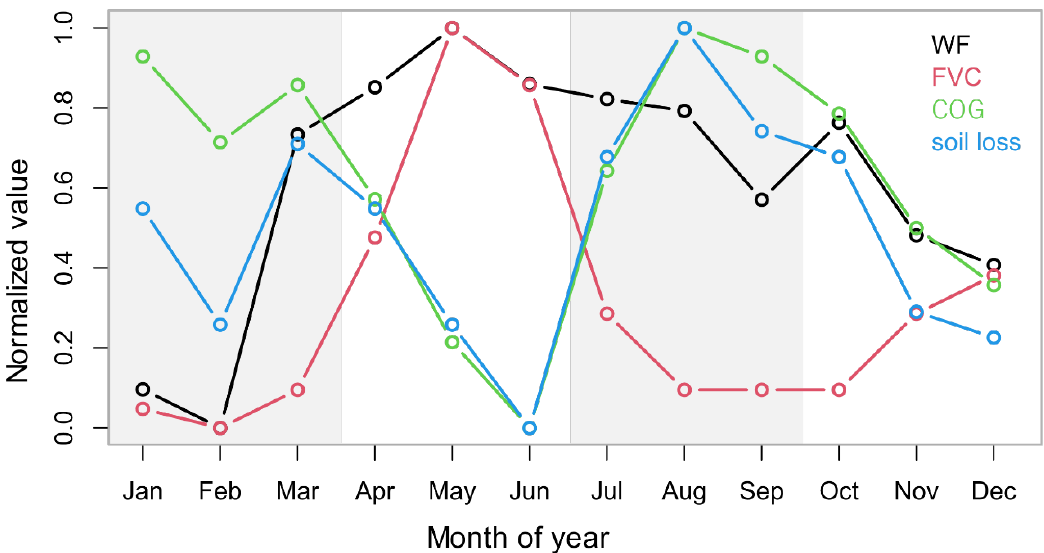
Figure 8. Monthly variation of revised wind equation factors and soil loss on a max-min-normalized scale (see Equation (20)). Abbreviations: WF, weather factor; FVC, mean monthly fraction of vegetation cover; COG, combined crop factor.